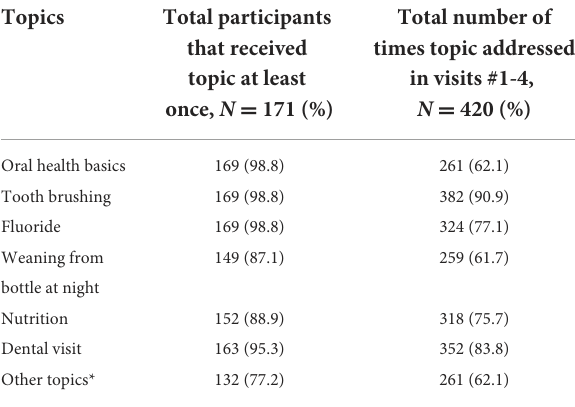
TABLE 1 Oral health topics covered by oral community health